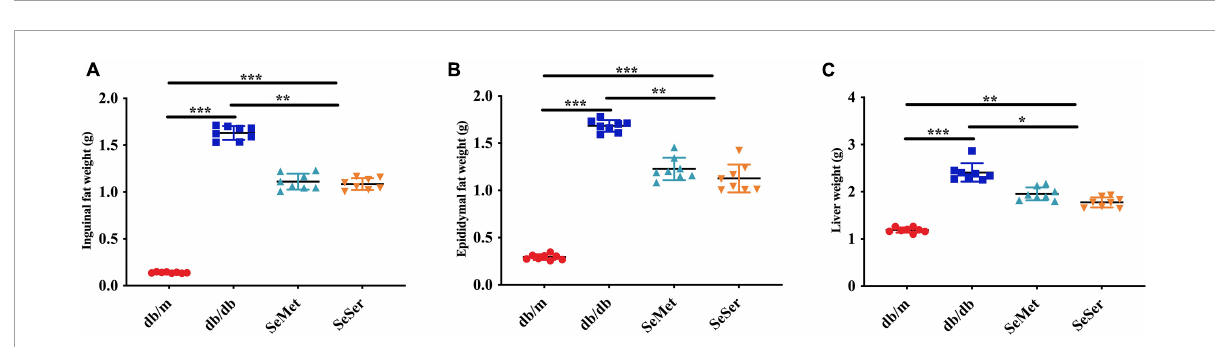
FIGURE2 Administration of selenomethionine and serine decreased liver and fat weight in db/db diabetic mice. (A) Inguinal fat weight; (B) epididymal fat weight; (C) liver weight. Values are expressed as mean ± SEM, n = 8. * P < 0.05, ** P < 0.01, *** P <